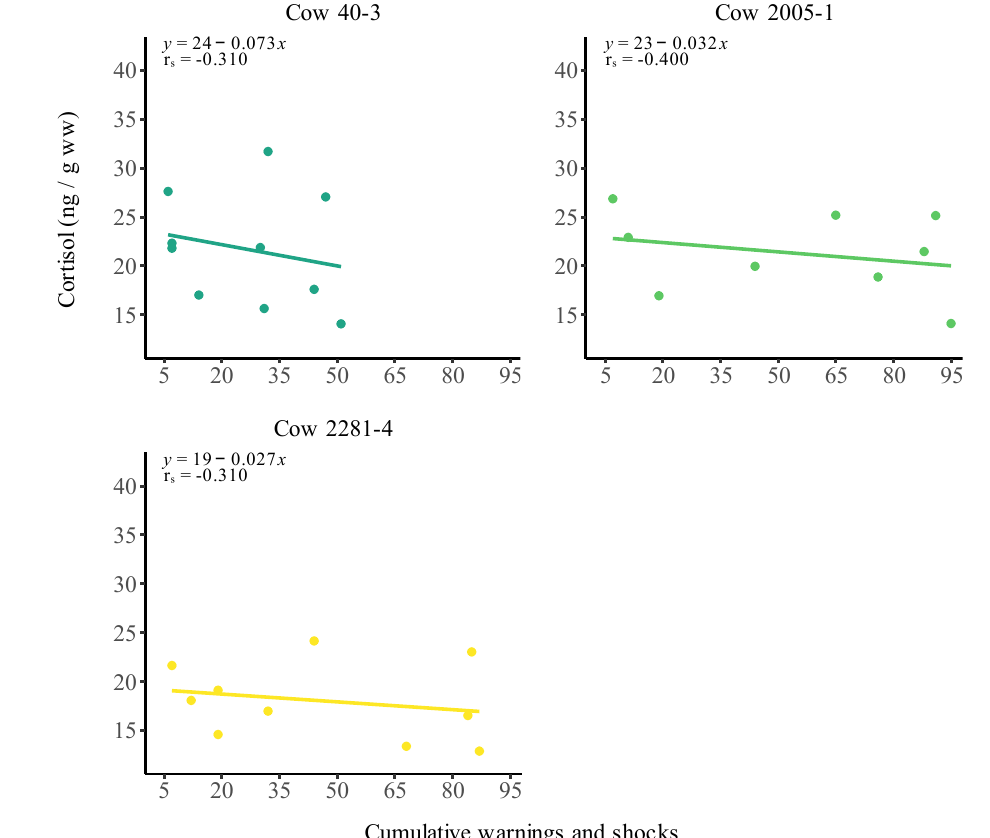
Figure 5. Linear regression of cortisol concentration in relation to the cumulative number of auditory warnings and electric impulses received for each individual during the study period of May 29 to June 15. The regression equation and Spearman correlation coefficient (r s ) are given in each plot. New colour for each cow.